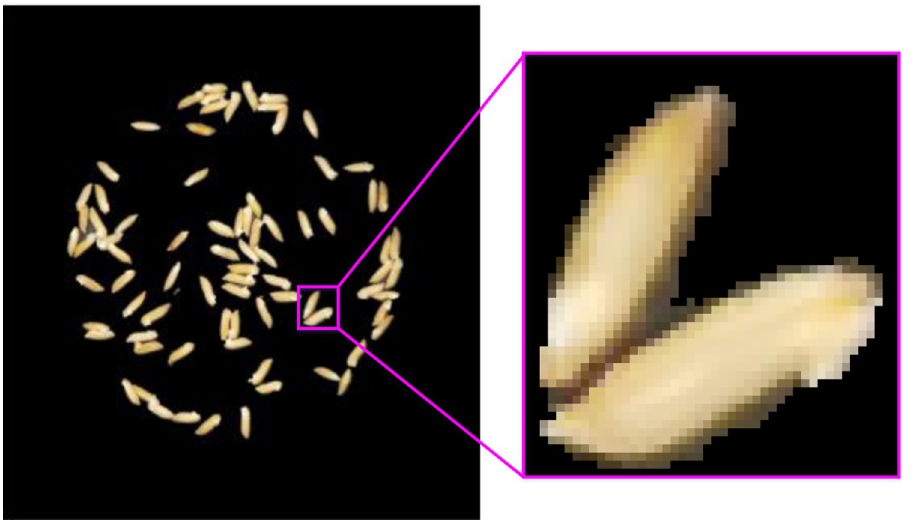
Fig 3. Magnified